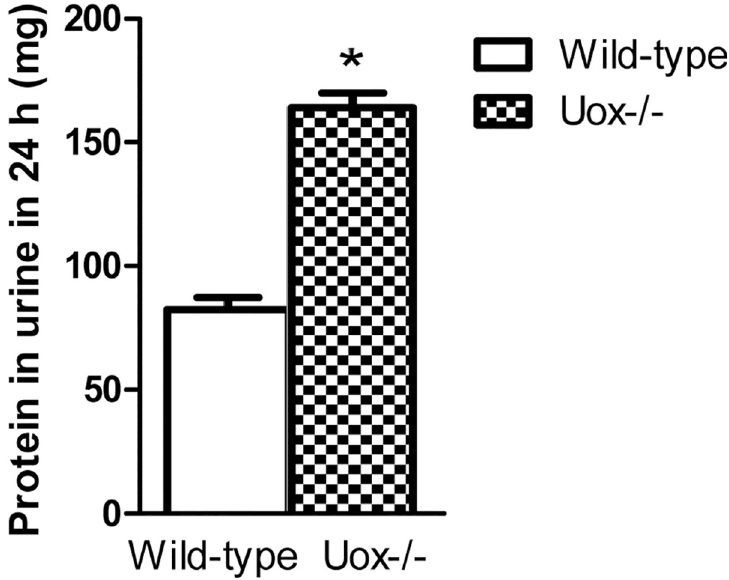
Fig 9. Protein in the urine excreted by the Wild-Type (WT) and Uox -/- rats in 24 h who weighing 180–220 g (mean ± SD, n = 10). � P < 0.05, vs the wild-type rats, one-way ANOVA.